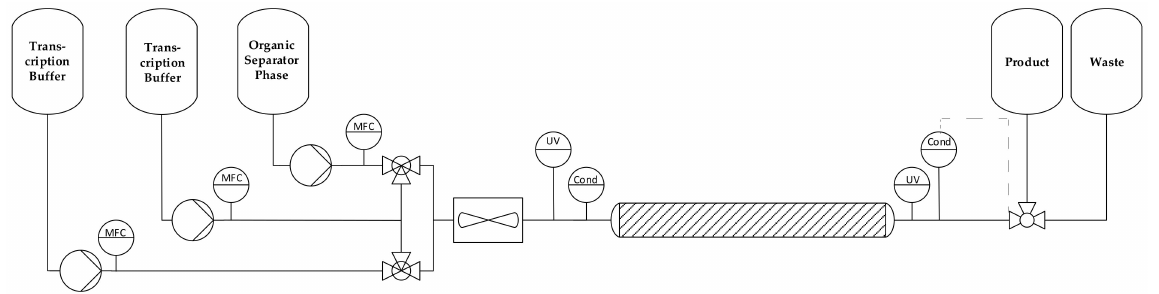
Figure 5. Setup of the test unit in which the segmented slugs are generated, detected, and fractionated by the resulting detection signal.